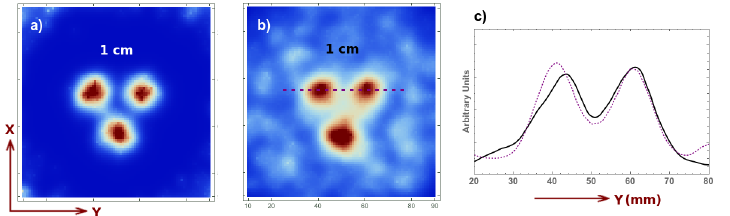
Figure 12. Image reconstruction for a 1.8 s acquisition of a 1 cm Derenzo and 0.05 Mbq activity for each sphere, at 5 cm from the collimator without background ( a ), with background ( b ) (8:1 signal to background ratio) and its profile ( c ) for the current acquisition (dotted purple curve) and for the previous acquisition (solid black